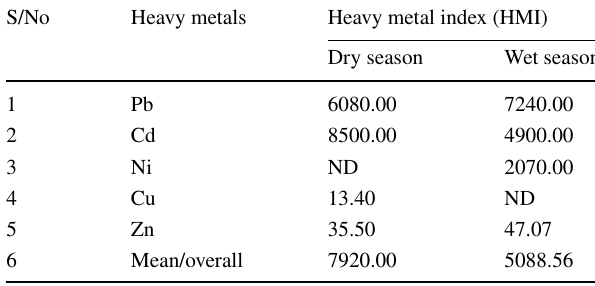
Table 3 Heavy metal index for River